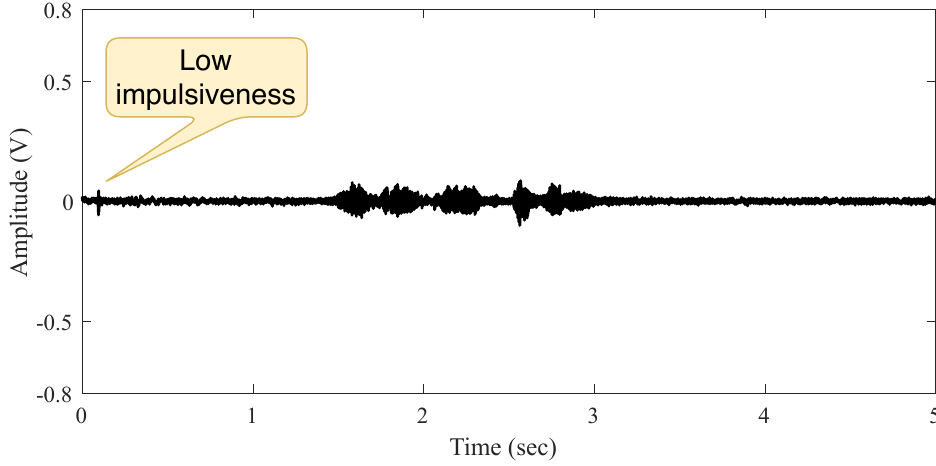
Figure 7. Signal behavior in the hall scenario with a person moving and